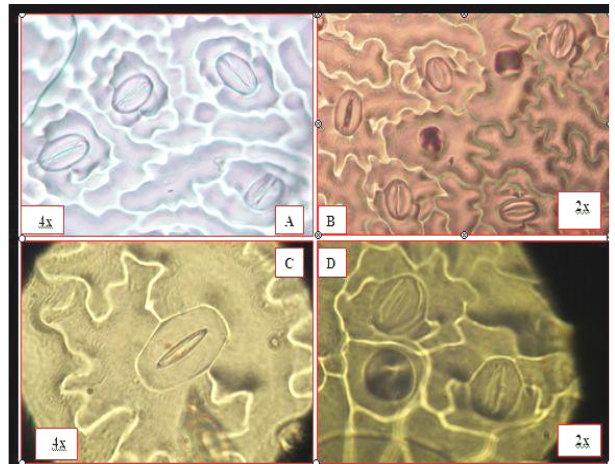
Fig. 4. Comparison of stomata density and size of tetraploid (A, C) and diploid (B, D) plants (A, B 40X and C, D 100X magnification)